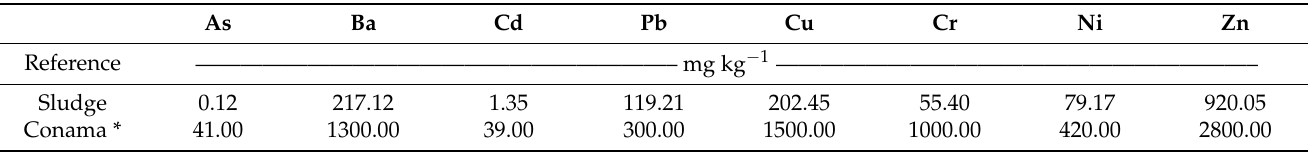
Table 1. Heavy metal total contents of the sewage sludge used as a substrate to produce Samanea saman seedlings with different substrates and inoculation